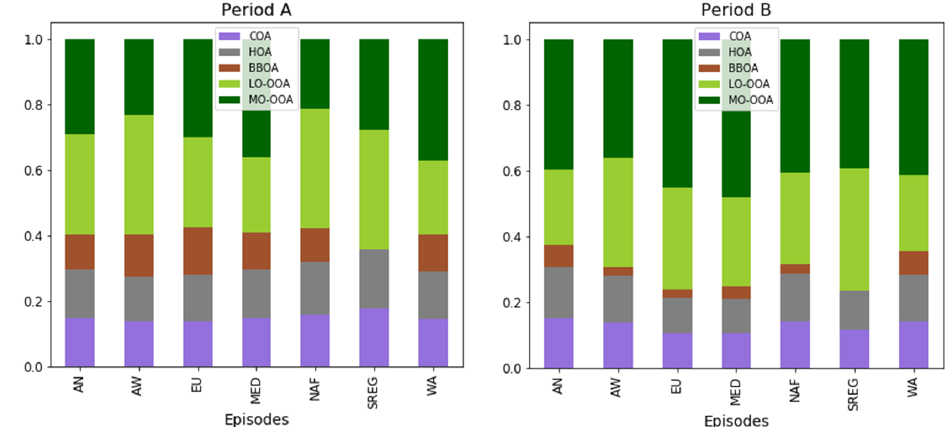
Figure 8. Bar chart of factor proportion to total concentrations per factor grouped by episodes for periods A and